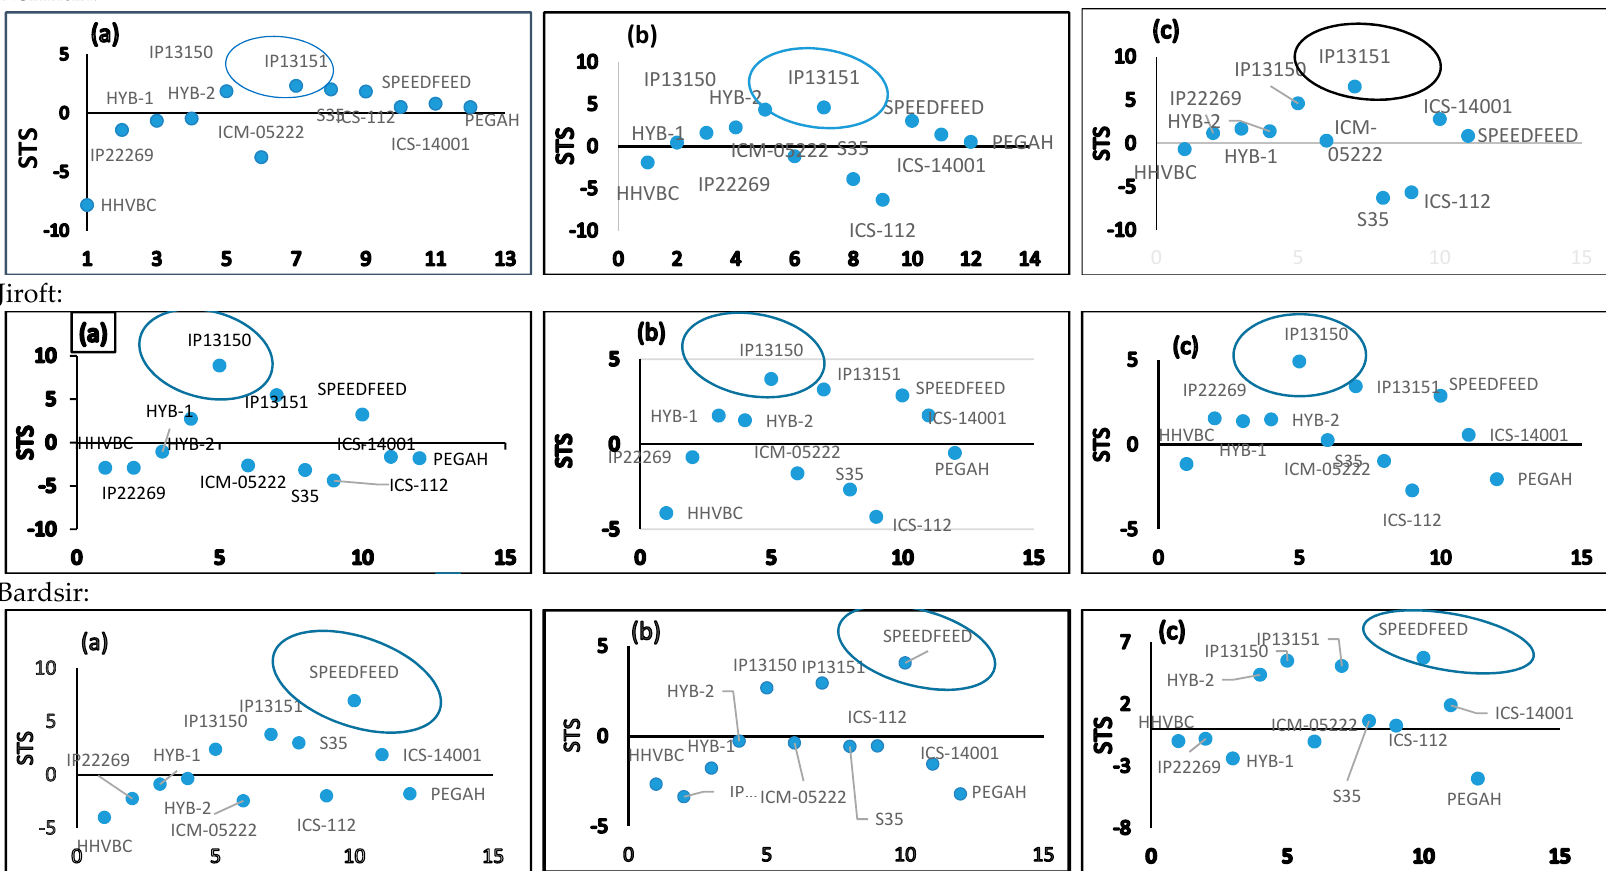
Figure 2. Bi-plot based on the stress tolerance score (STS) in genotypes pearl millet and sorghum in three years. ( a ) 2016, ( b ) 2017, and ( c ) 2018.